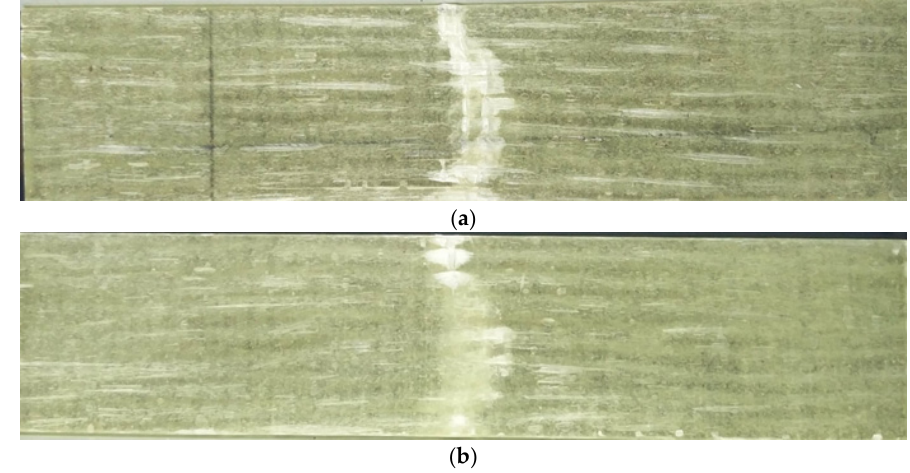
Figure 10. Photos of a specimen which failed under quasi ‐ static bending; ( a ) top surface, ( b ) bottom surface.